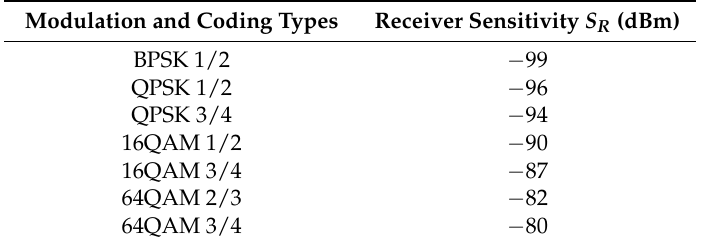
Table 1. Receiver sensitivities for different modulation and coding types